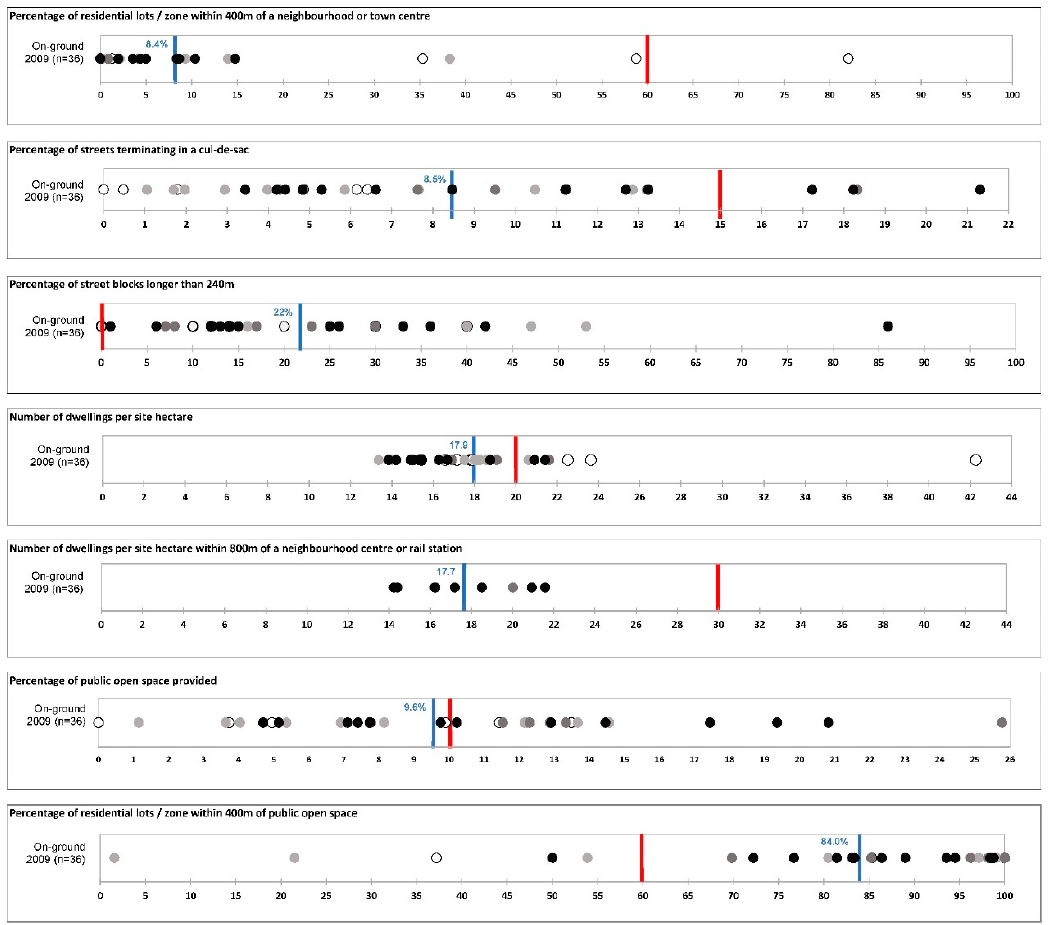
Figure 1. Compliance scores on selected design requirements measured in 36 housing developments on-the-ground in 2009 and approved development applications in 2015. Top = on-ground 2009 ( n = 36): ○ Small subdivision ≤ 60 hectare ( n = 8); ● Large subdivision >60 hectares ≤ 100 hectares ( n = 10); ● Structure plan >100 hectares ≤ 300 hectares ( n = 5); ● Regional master plan >300 hectares ( n = 13); Indicates the Liveable Neighbourhoods policy target for the respective design feature; | Indicates the average level of compliance across the 36 housing developments.